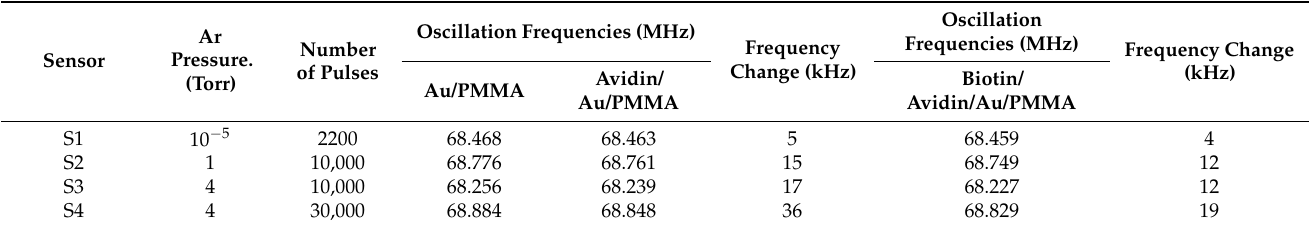
Table 1. Oscillation frequencies of sensors S1–S4 after deposition of avidin and biotin layers on top of Au layers. Ar Pressure. Sensor